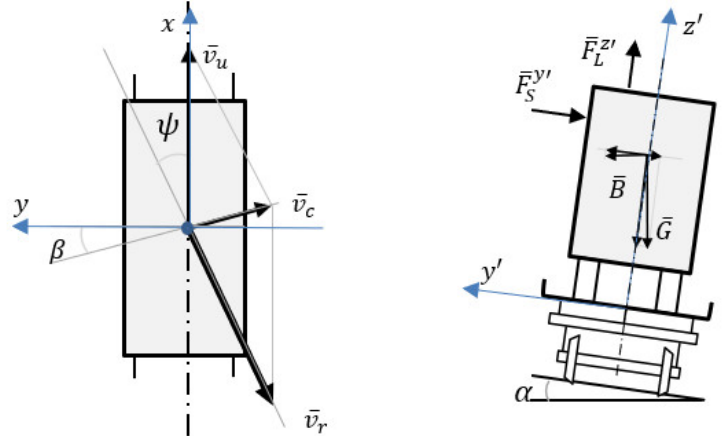
Figure 6. Relative airflow velocity v r and aerodynamic forces.